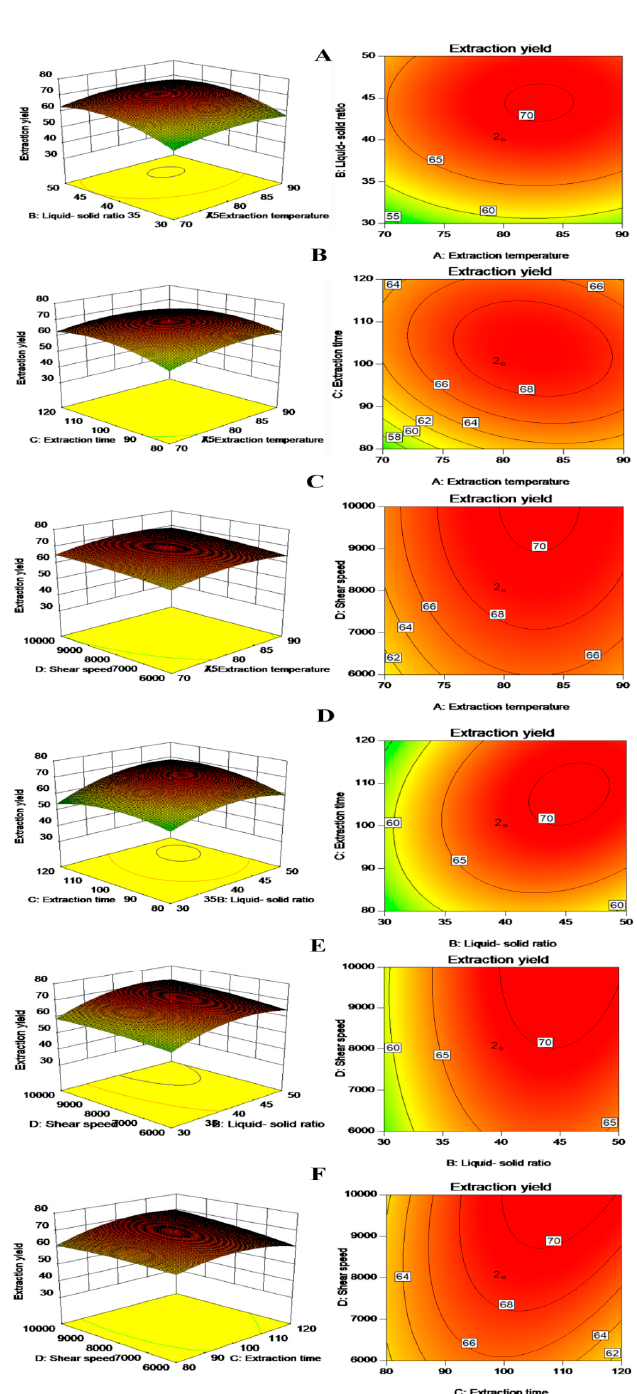
Figure 1. The 3D response surface and 2D contour plots showing the e ff ects of extraction factors on the yield of BS mucilage. ( A ) 3D response surface and 2D contour plots showing the e ff ects of liquid–solid ratio and extraction temperature on the yield of BS mucilage; ( B ) 3D response surface and 2D contour plots showing the e ff ects of extraction time and extraction temperature on the yield of BS mucilage; ( C ) 3D response surface and 2D contour plots showing the e ff ects of shear speed and extraction temperature on the yield of BS mucilage. ( D ) 3D response surface and 2D contour plots showing the e ff ects of extraction time and liquid–solid ration on the yield of BS mucilage. ( E ) 3D response surface and 2D contour plots showing the e ff ects of shear speed and liquid–solid ratio on the yield of BS mucilage. ( F ) 3D response surface and 2D contour plots showing the e ff ects of shear speed and extraction time on the yield of BS